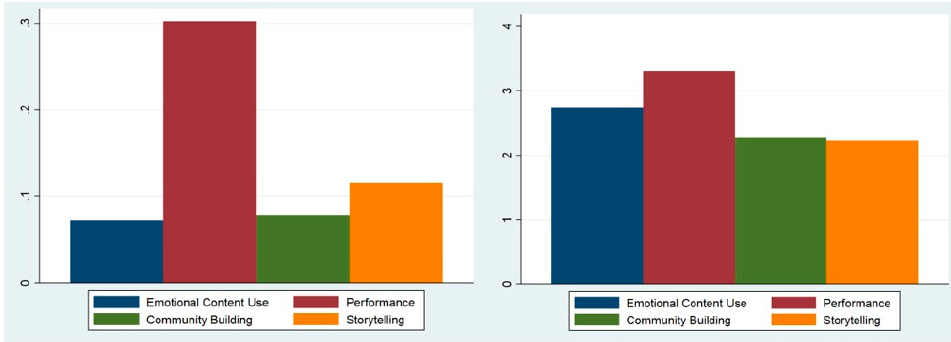
Figure 4. R-Squared ( Left ) and Odds-Ratio ( Right ) Values.